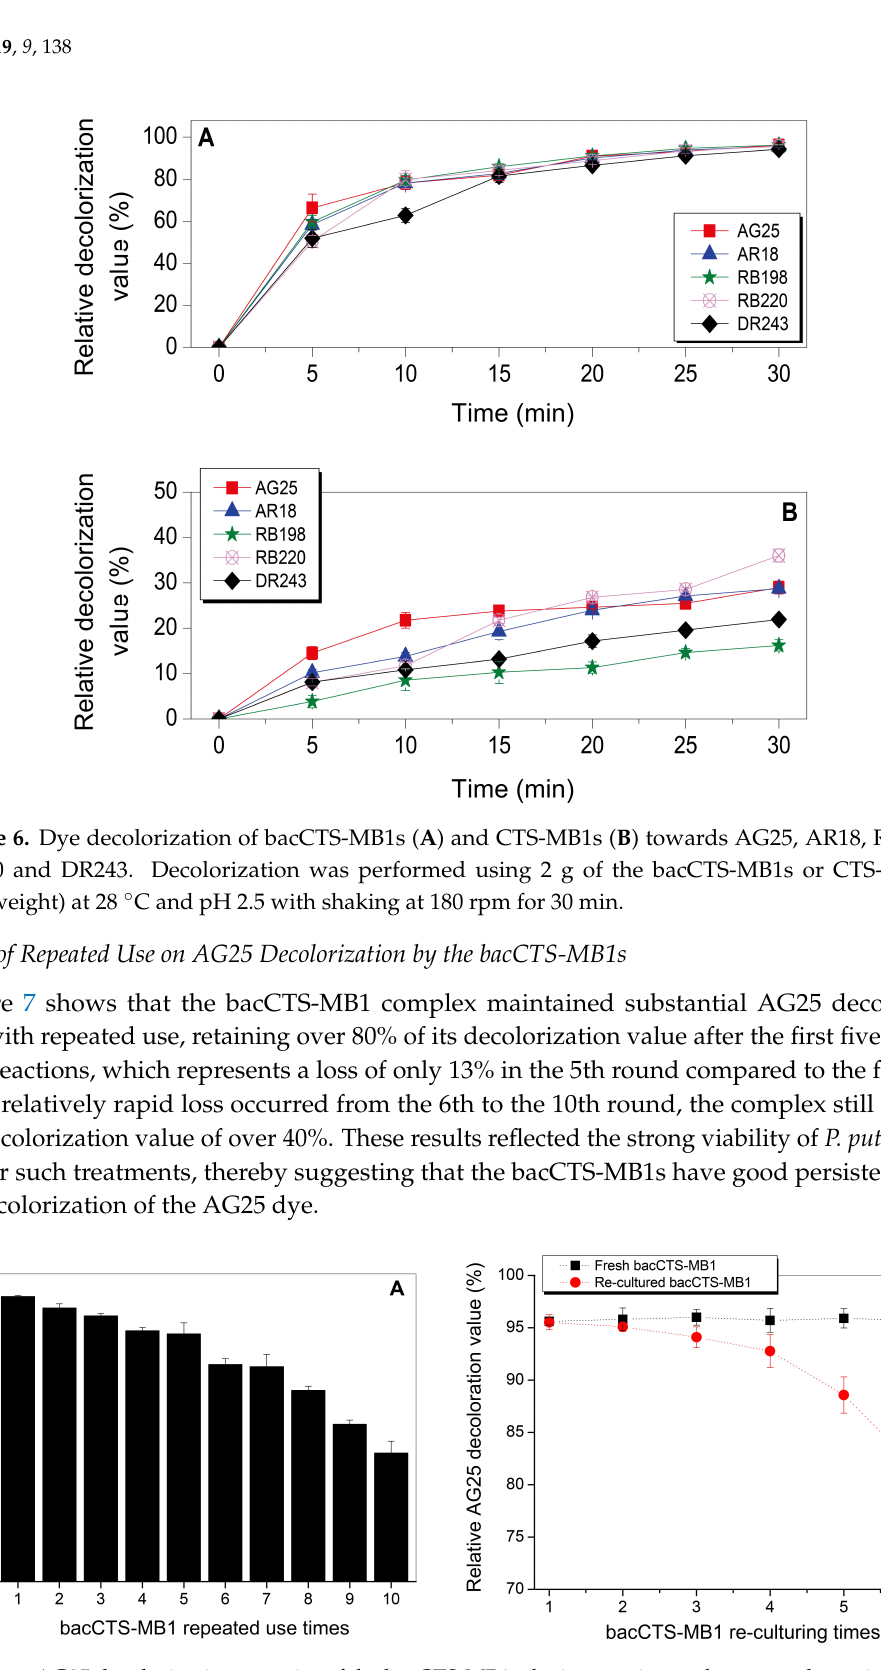
AG25, 95.6% for AR18, 96.3% for RB198, 95.7% for RB220 and 94.3% for DR243 in 30 min (Figure 6A);